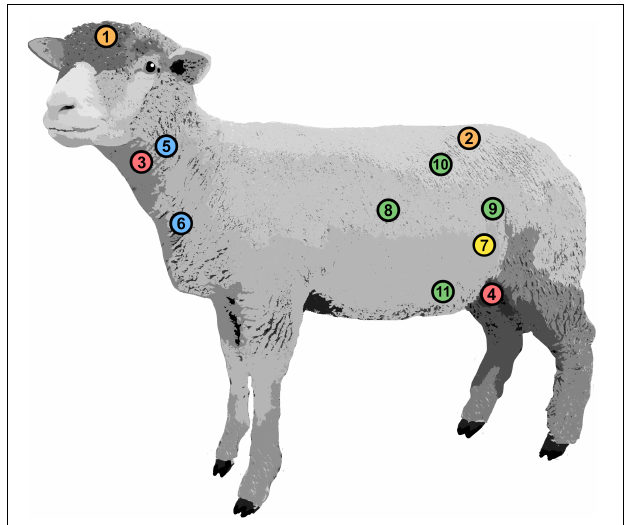
FIGURE 1 | Positions of implanted pressure probes. Intracranial pressure (1), intrathecal pressure (2), carotid arterial pressure (3), femoral arterial pressure (4), jugular venous pressure (5), central venous pressure (6), intravesical pressure (7), intra-abdominal pressure: cranial (8), caudal (9), dorsal (10), and ventral